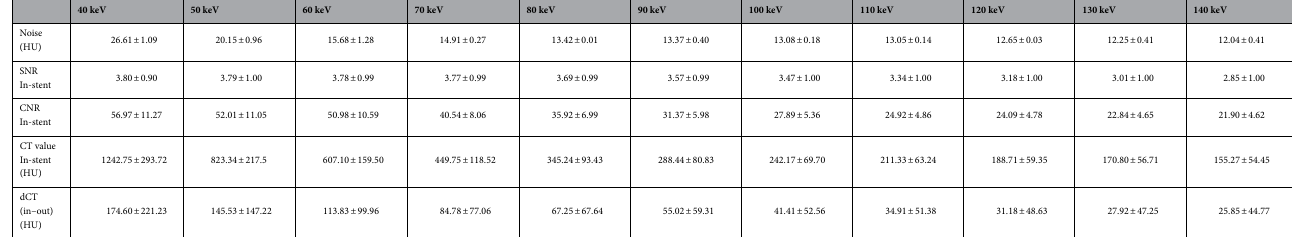
Table 1. Mean CT value In-stent and dCT(in–out) as well as image noise values and SNR of in-stent and CNR of in-stent for selected kiloelectron (keV). HU Hounsfield units, mean value ± standard deviation.